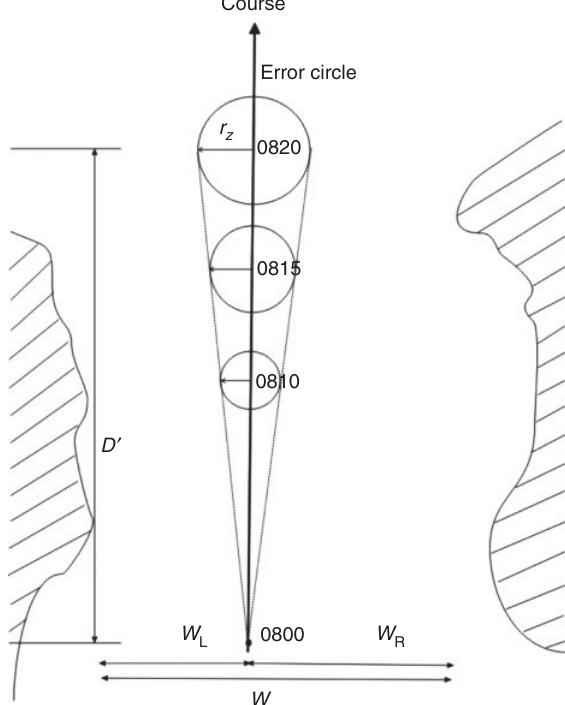
Fig. 3. Fix expansion and error circle around the DR